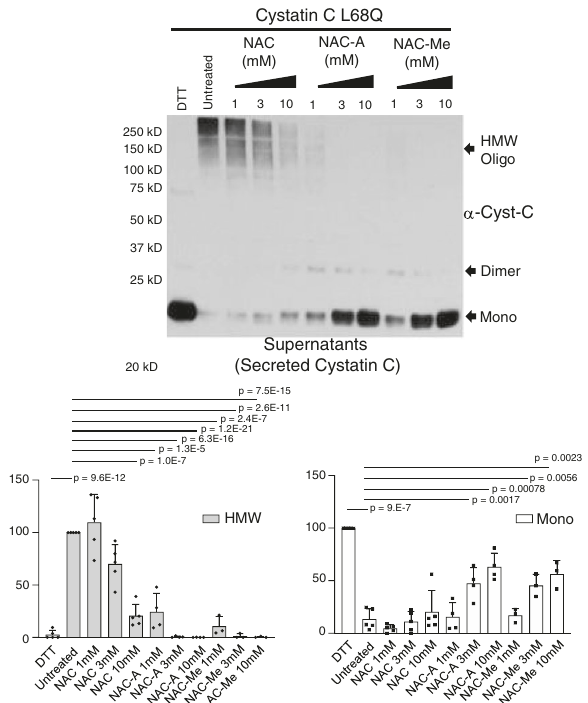
Fig. 5 NAC derivatives impairs oligomerization of secreted hCC L68Q. Supernatants were incubated in the presence of the indicated concentrations of n-acetyl cysteine (NAC), NAC amide (NACA), or NAC- Methyl esther (NAC-Me) for 1 h. Samples were mixed with 2% SDS without reducing agents prior to electrophoresis, protein levels were detected by anti-cystatin C antibody, and amounts of monomeric hCC (Mono) or high-molecular-weight hCC species (HMW) were quantitated ( N = 5 independent experiments, 2 containing only NAC-A and 3 containing NAC-A and NAC-Me; one-tailed student t test; indicated p values were less than 0.05, without correction for multiple testing, with respect to untreated). Bars are means, error bars represent standard deviation. Gel images for replicate experiments are shown in Supplementary Fig.